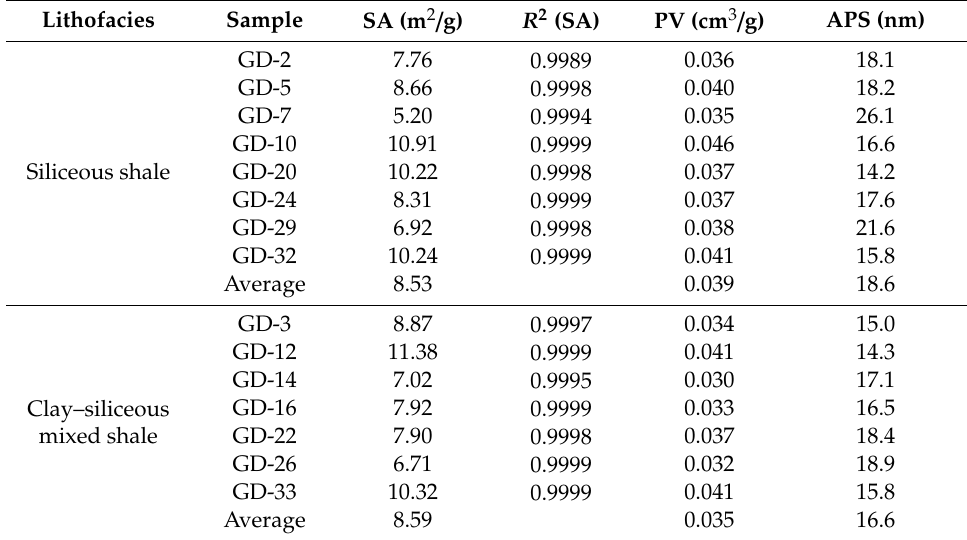
Table 4. Pore structure parameters of the Dalong Formation